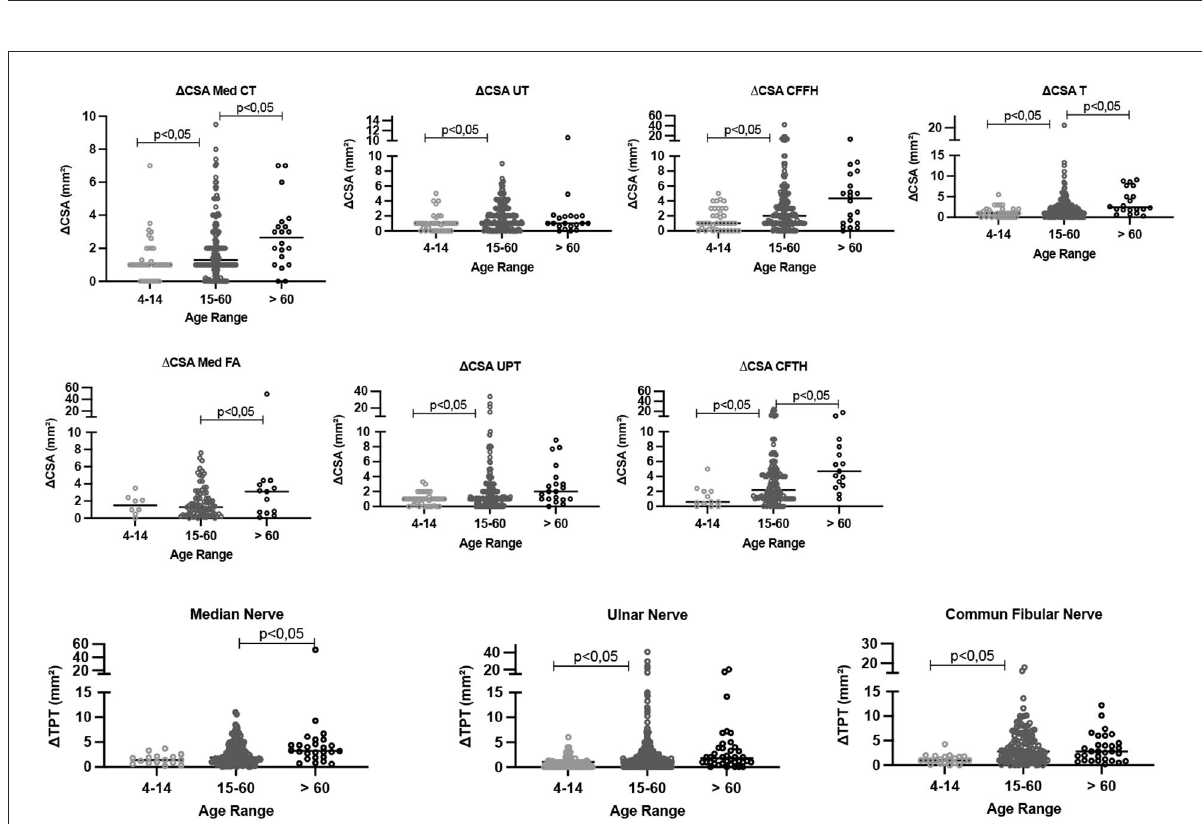
FIGURE4 Comparative analysis of the difference between the right and left CSA values ( 1 CSA) and the values in the same nerve ( 1 TPT) according to age range. CSA, cross-sectional area; Med CT, median carpal tunnel; Med FA, median forearm; UT, cubital ulnar tunnel; UPT, cubital ulnar pretunnel; CFFH, common fibular in the fibula head; CFTH, common fibular thigh; T, tibial. 1 CSA, difference between the right and the left nerve at the same site of assessment, 1 TPT, difference between different sites of the same